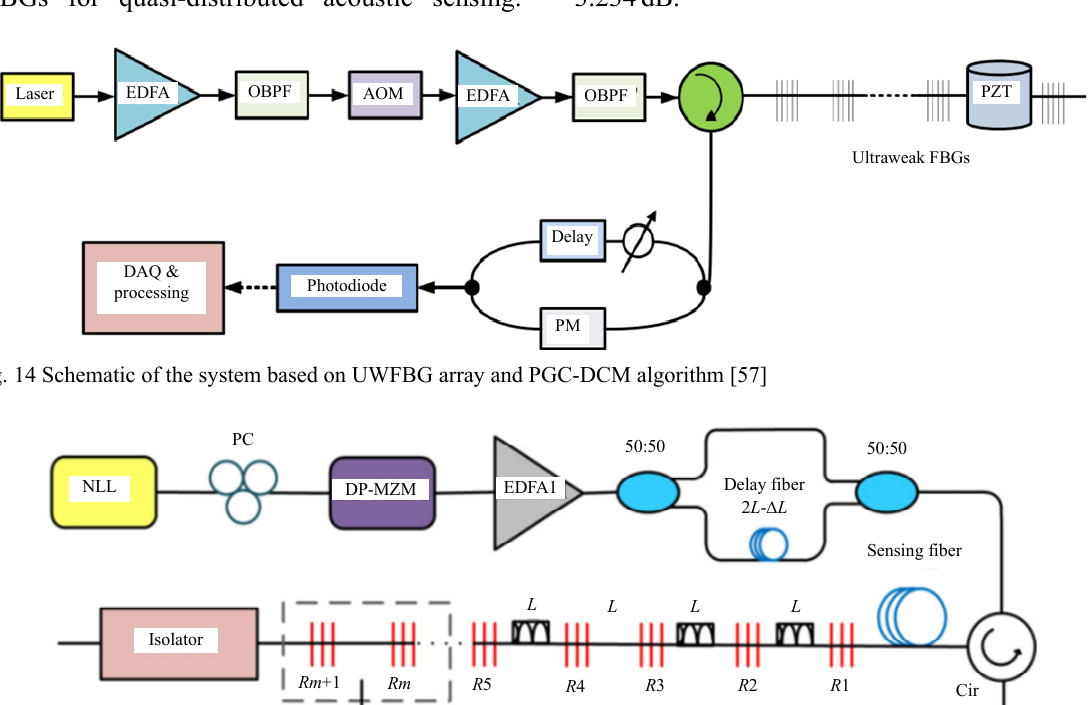
Rm +1 Dual-chirped pulses interference model